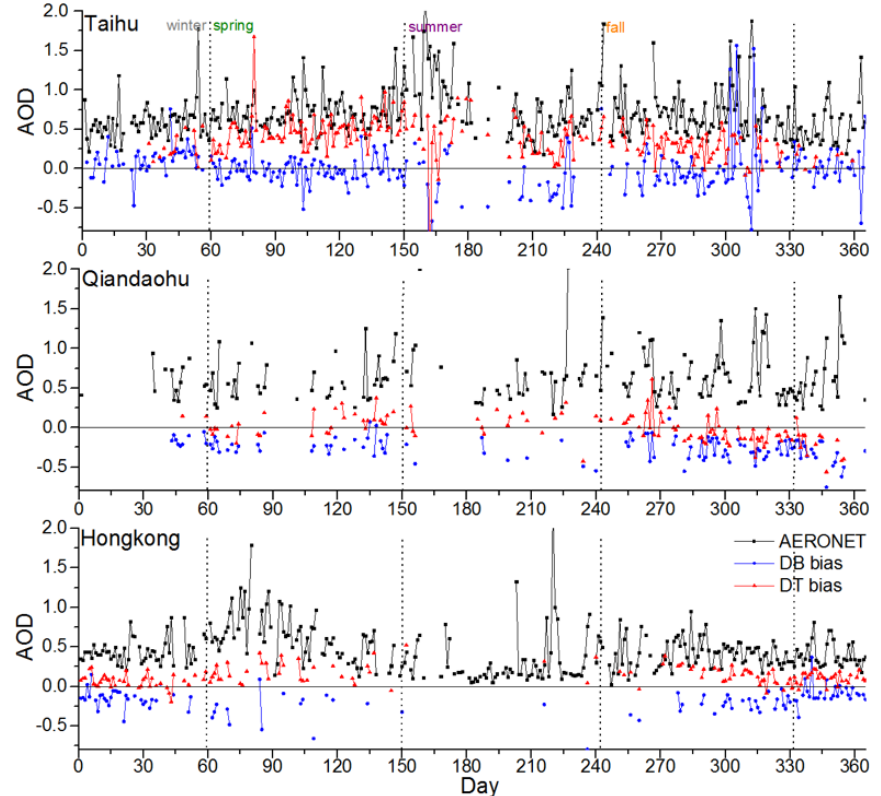
Figure 6. Daily mean values of AERONET AOD (black curve) and bias of MODIS DB and DT AOD (red and blue curves, respectively) when AERONET AOD 550 > 0.4 in Taihu, Qiandaohu, and Hongkong.